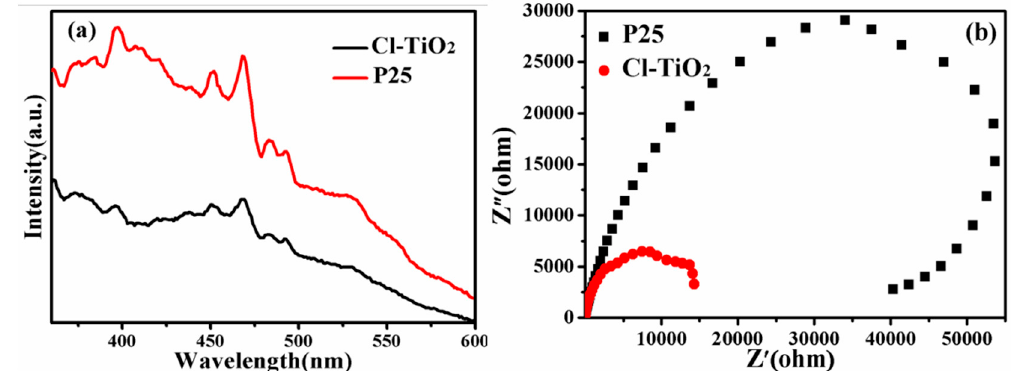
Figure 8. ( a ) PL spectra, ( b ) EIS spectra of P25 and Cl-TiO 2 .